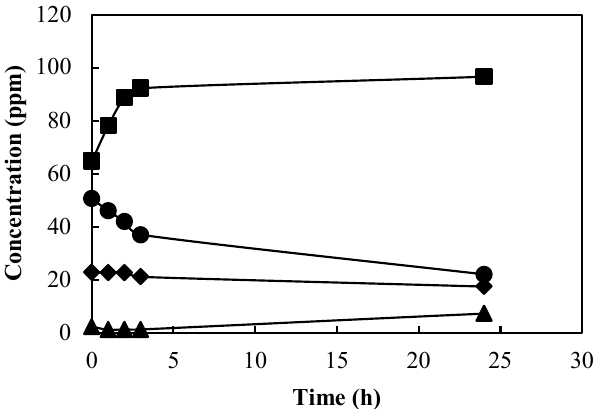
Figure 5. Effect of ( A , B ) pH and ( C , D ) temperature on the initial reaction rate of enzymes immobi ‐ lized in BGA ( A , C ) and OGA ( B , D ) using ∎ p NPG and ⯅ p NPR. 2.3. Debittering Grapefruit Juice adsorption of limonin over naringin has also been observed with the use of neutral resin, First, the commercial enzymatic preparation (free enzyme) was used for grapefruit as in the case of XAD-4 and XAD-7 [13]. juice debittering. Figure 6 shows the kinetics of naringin, prunin, naringenin, and limonin concentrations. Naringin concentration decreased over time with a subsequent increase in prunin concentration, reflecting the α‐ L ‐ rhamnosidase activity. After 24 h of reaction, there was a 56% reduction in the initial concentration of naringin. Naringenin concentra ‐ tion increased after 24 h of reaction, indicating lower β‐ D ‐ glucosidase activity. Limonin was not affected by the action of the enzyme, as expected, and a 23% reduction after 24 h was observed in a control sample (data not shown), which may be explained by the de ‐ composition of the molecule.